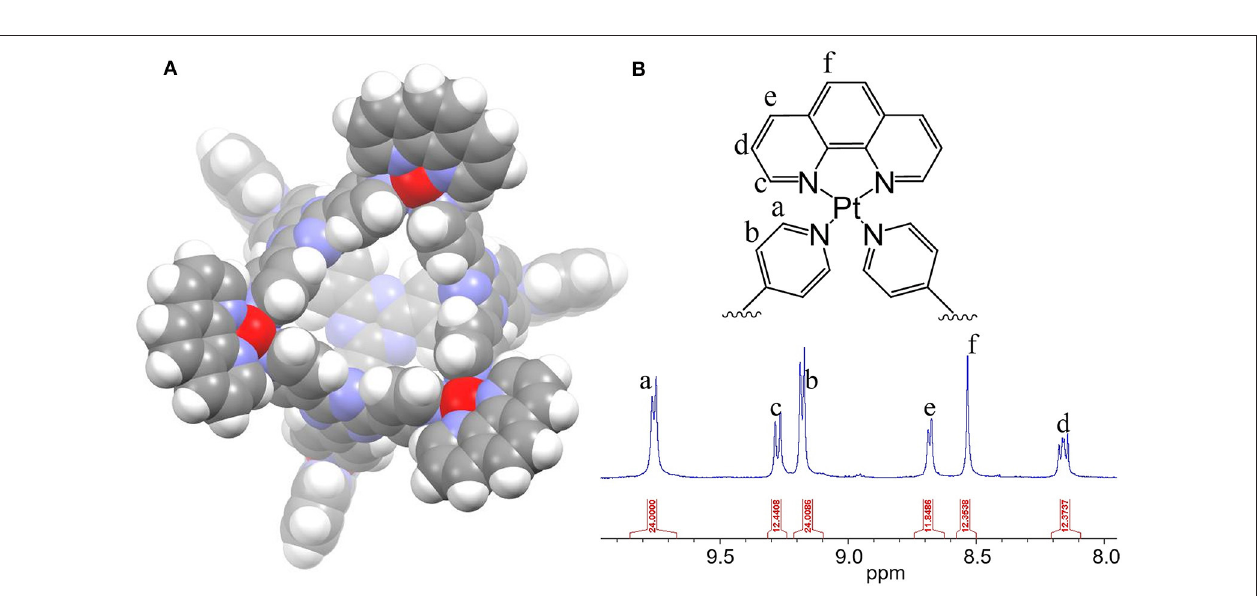
Preparation of the Nanoparticles of Metal-Organic Cages